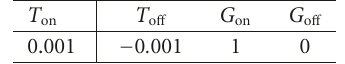
Table A.10: Parameters of a hysteresis controller of test system